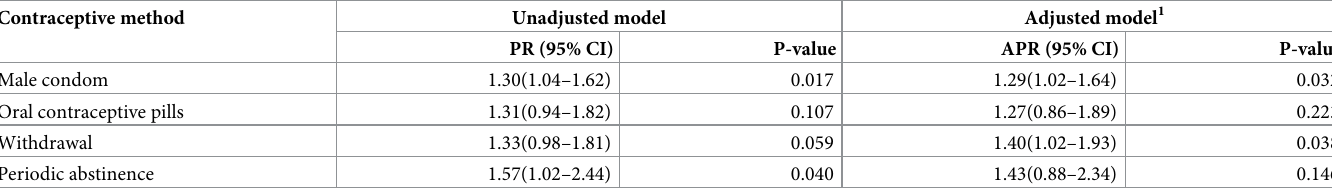
Table 4. Association between fertility awareness knowledge and methods of contraceptive